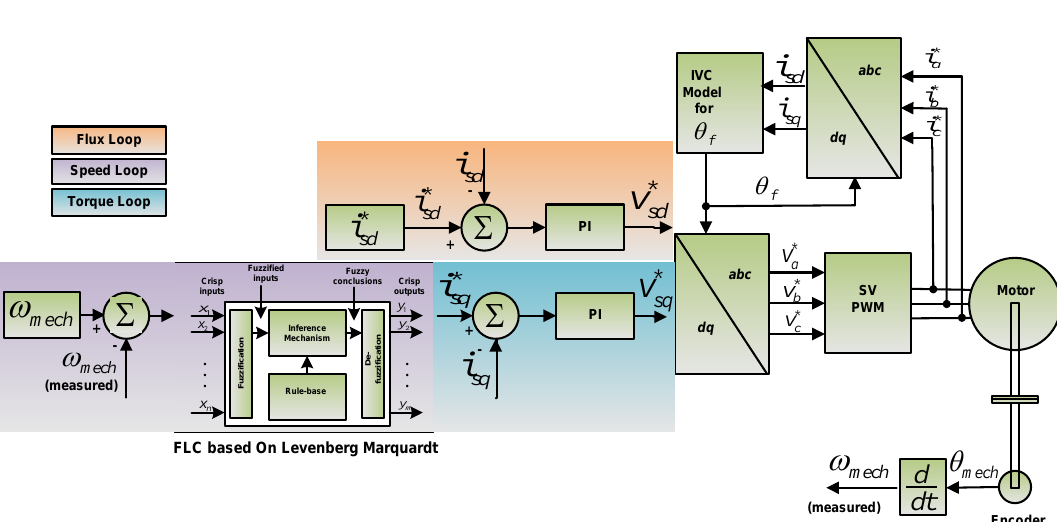
Figure 7. Fuzzy Logic Control (FLC) based on the Levenberg-Marquardt (LM) algorithm.